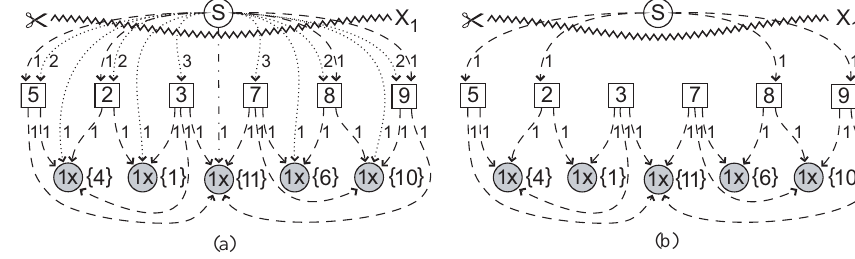
Figure 8. Loop connection graph for the kinematical network of Fig. 7 (a) with and (b) without isolated DOFs.